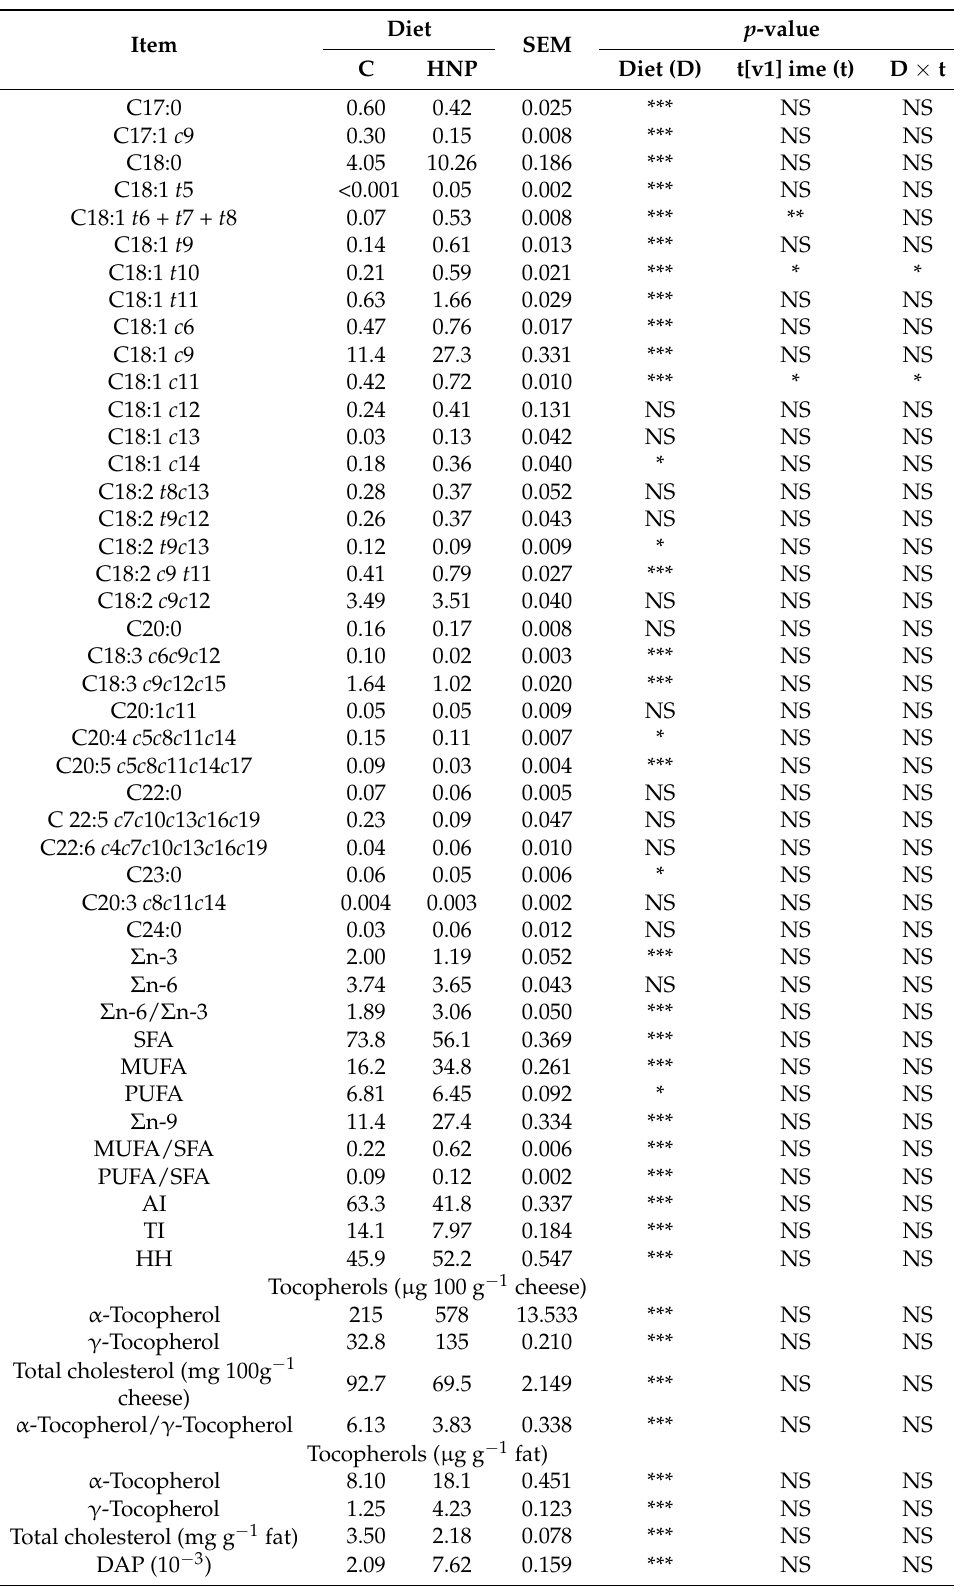
Abbreviations are: C, control diet; HNP, hazelnuts peels diet; t, shelf-life time. Σ n-6: (C18:2 c9c12 + t9c12 + C18:3 c 6 c 9 c 12 + C20:4 c 5 c 8 c 11 c 14); Σ n-3: (C18:3 c9c12c15 + C20:5 c 5 c 8 c 11 c 14 c 17 + C22:5 c 7 c 10 c 13 c 16 c 19 +